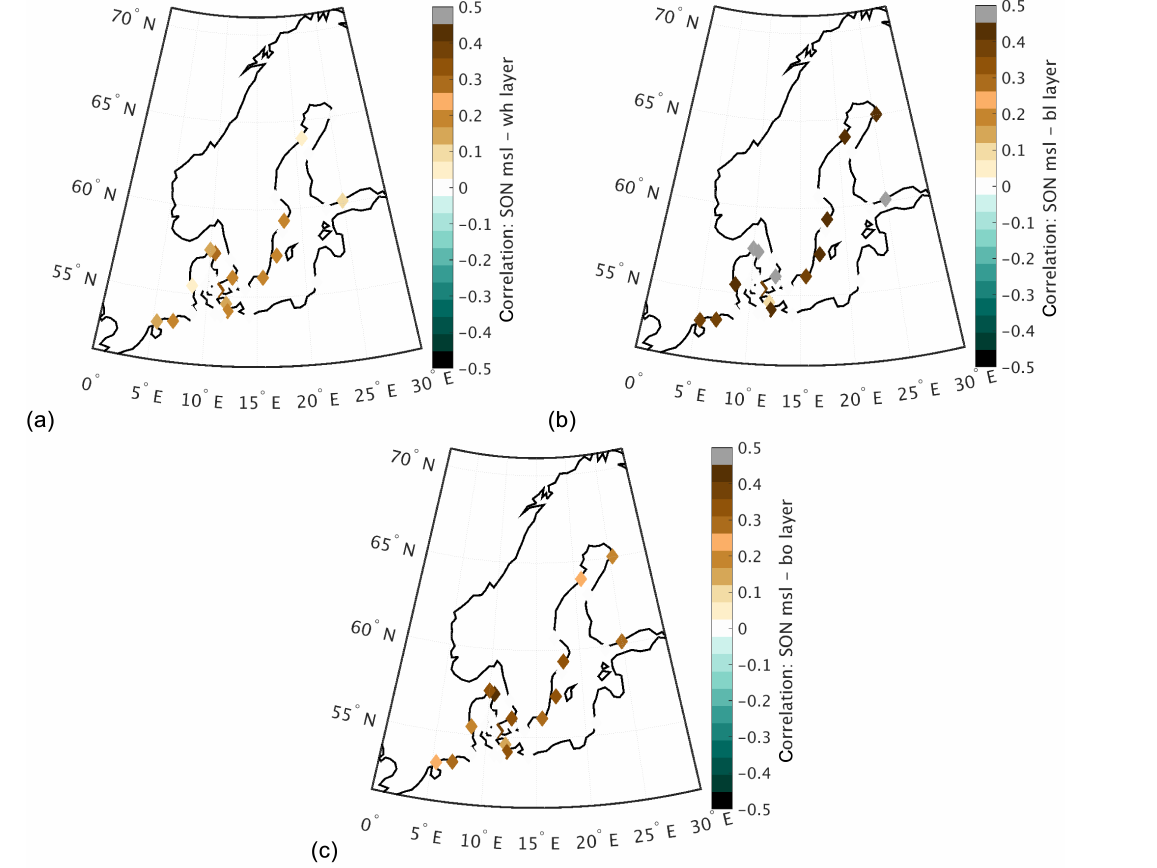
Figure 9. Spatial maps of correlation coefficients between the mean sea level data from Baltic coastal stations and the dune layer thickness during autumn (SON) for (a) the white layer, (b) the black layer, and (c) both layers combined.